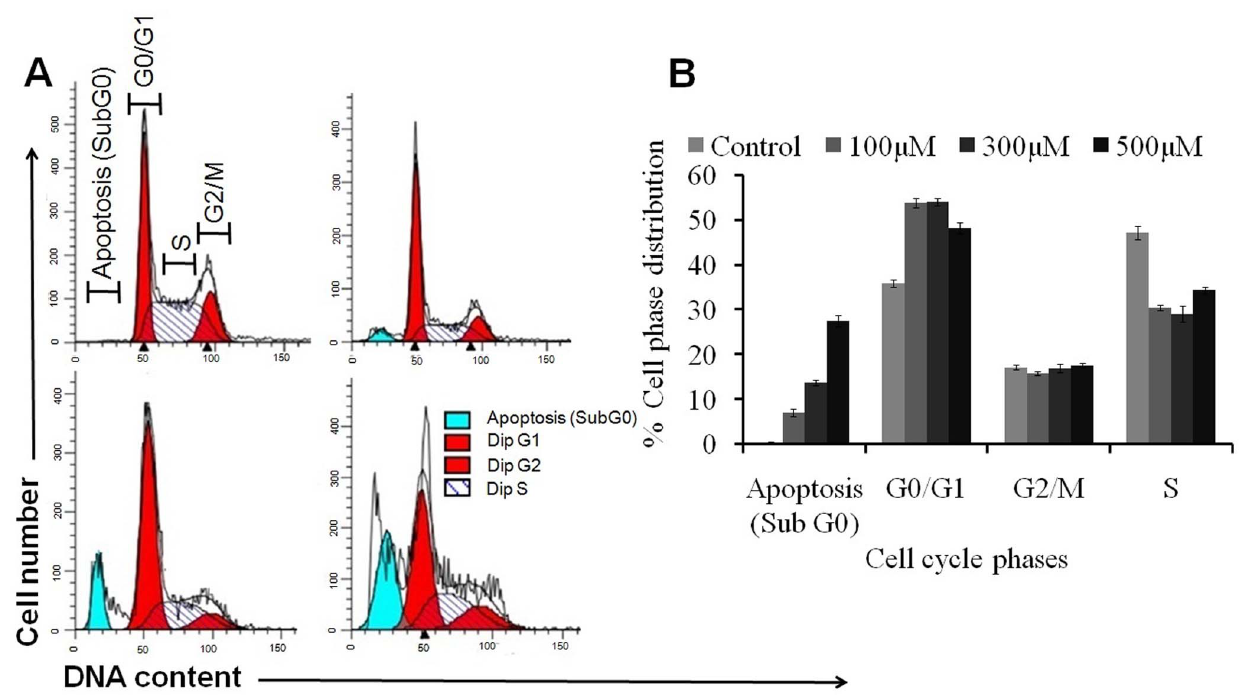
Figure 6. Effect of naringenin on different phases of cell cycle. A431 cells were treated with different concentrations of naringenin (100 m M 2 3 00 m M) for 24 h, stained with propidium iodide and measured by flow cytometry (A) Representative photomicrograph showing the apoptosis and phase distribution of cell population (B) Quantitative distribution of percentage of A431 cells in different phases of cell cycle treated with different concentrations of naringenin. Data is representative of three independent experiments.